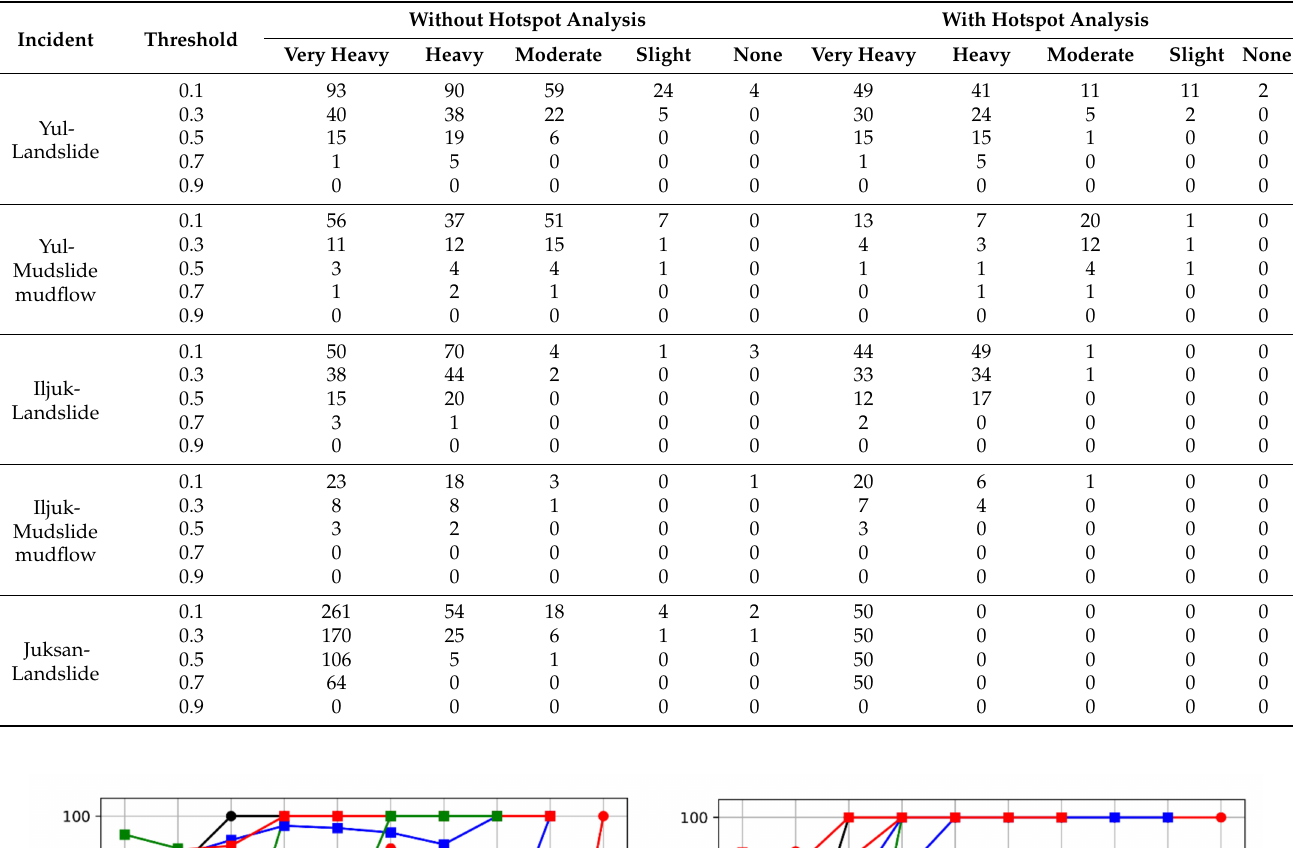
Table 5. Number of images classified by analysis (24–25 August dataset).